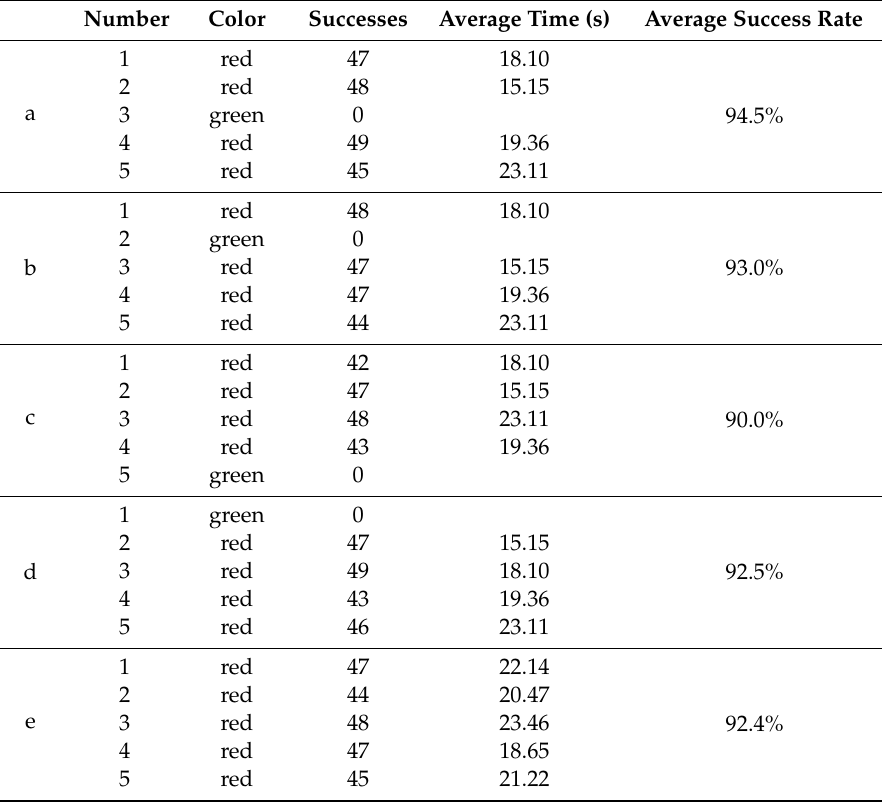
Table 5. Experimental